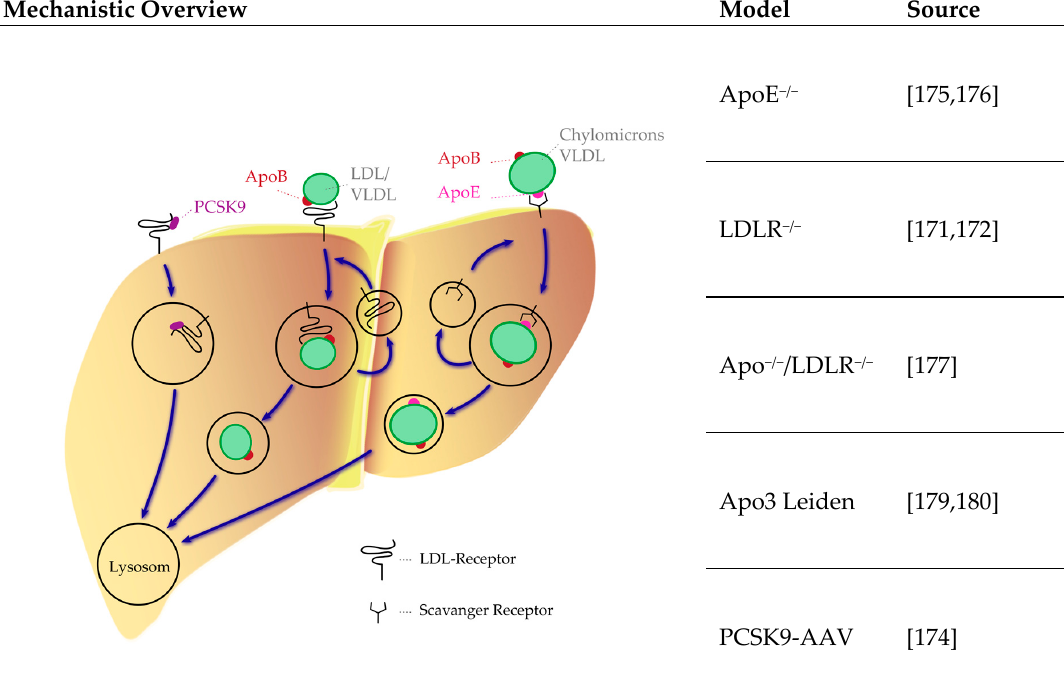
Figure 4. Mice models of atherosclerotic hyperlipidemia and their mechanisms. Blue arrows: